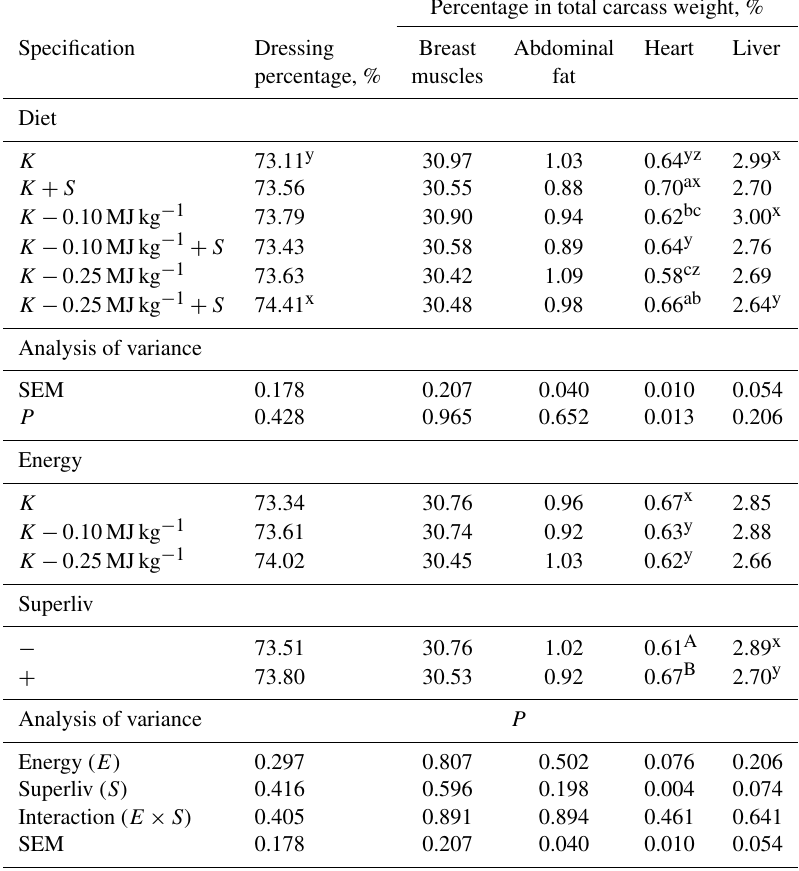
Table 4. Carcass